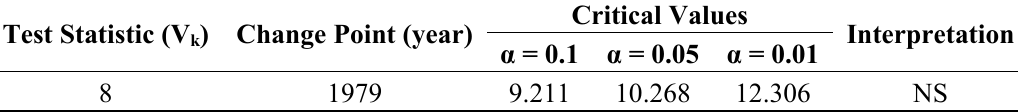
Table 3. Distribution free CUSUM test results.